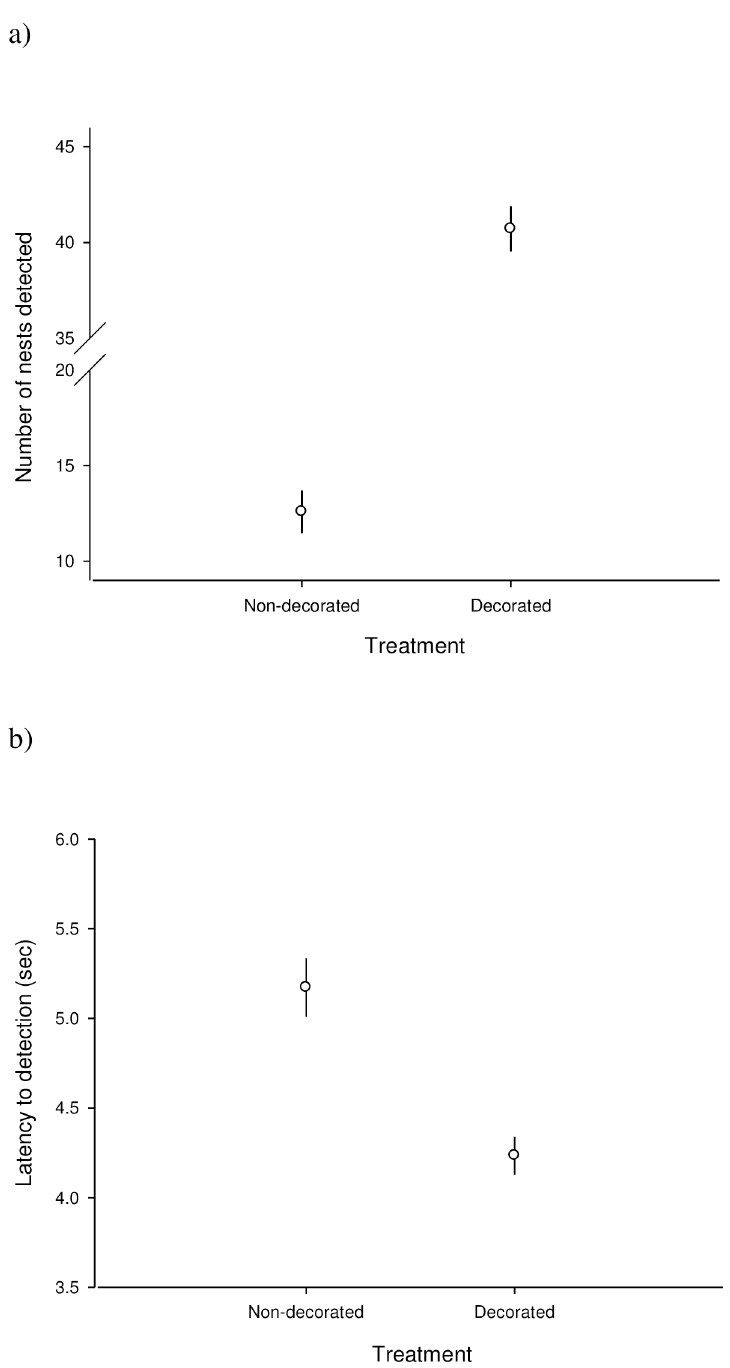
decoration treatment (decorated vs non-decorated nests; n = 150 images assessed by 25 volunteers for 15 nests, each measured as decorated or not). Bars represent 1 SE.